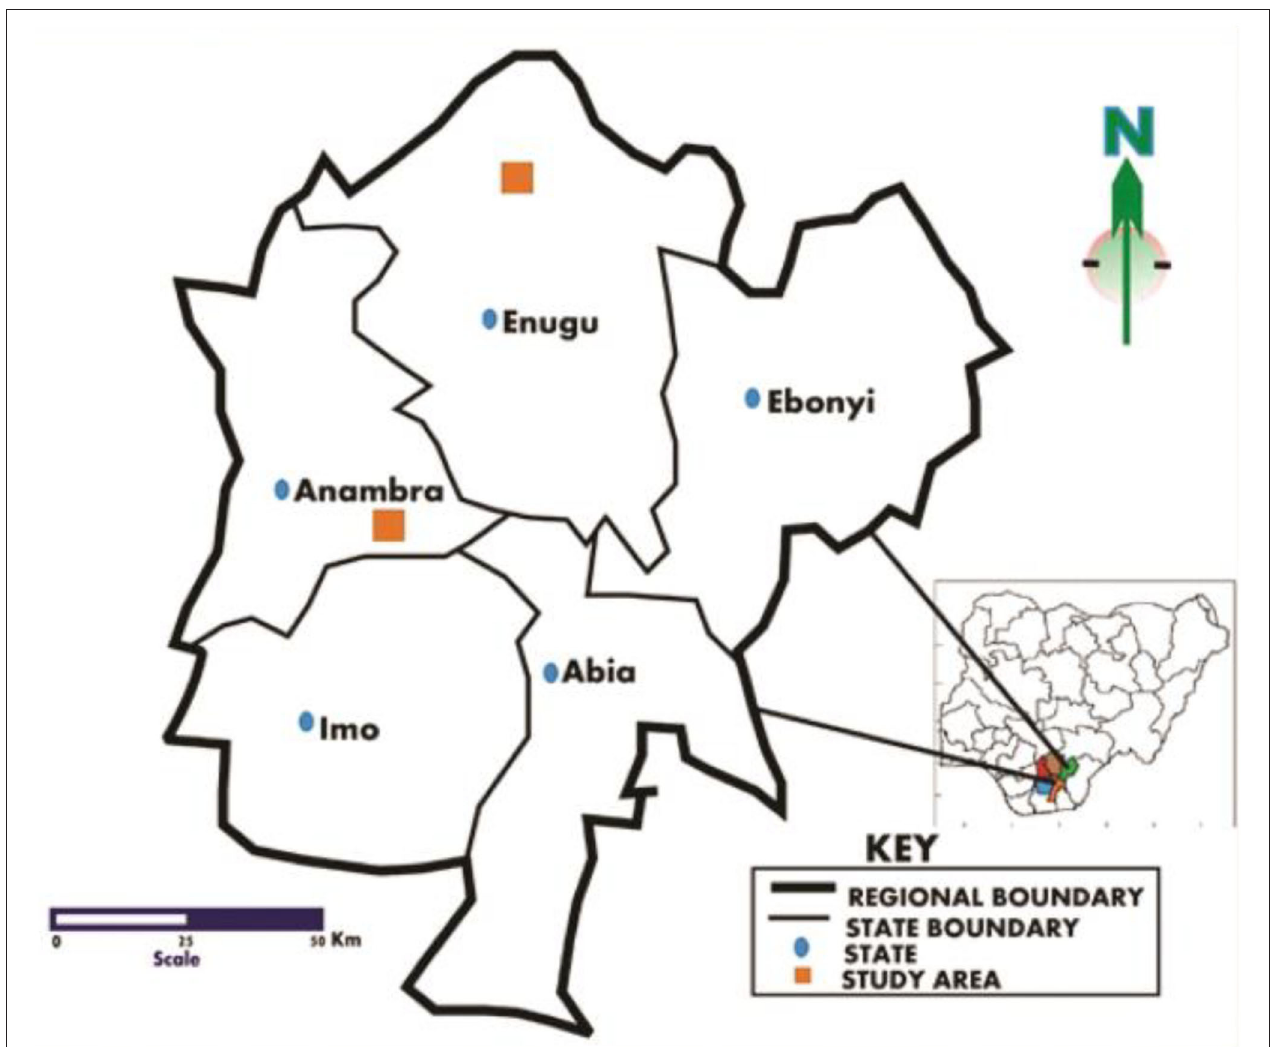
FIGURE 2 | Map showing the Southeast geographical zone of Nigeria. Source: Munonye,